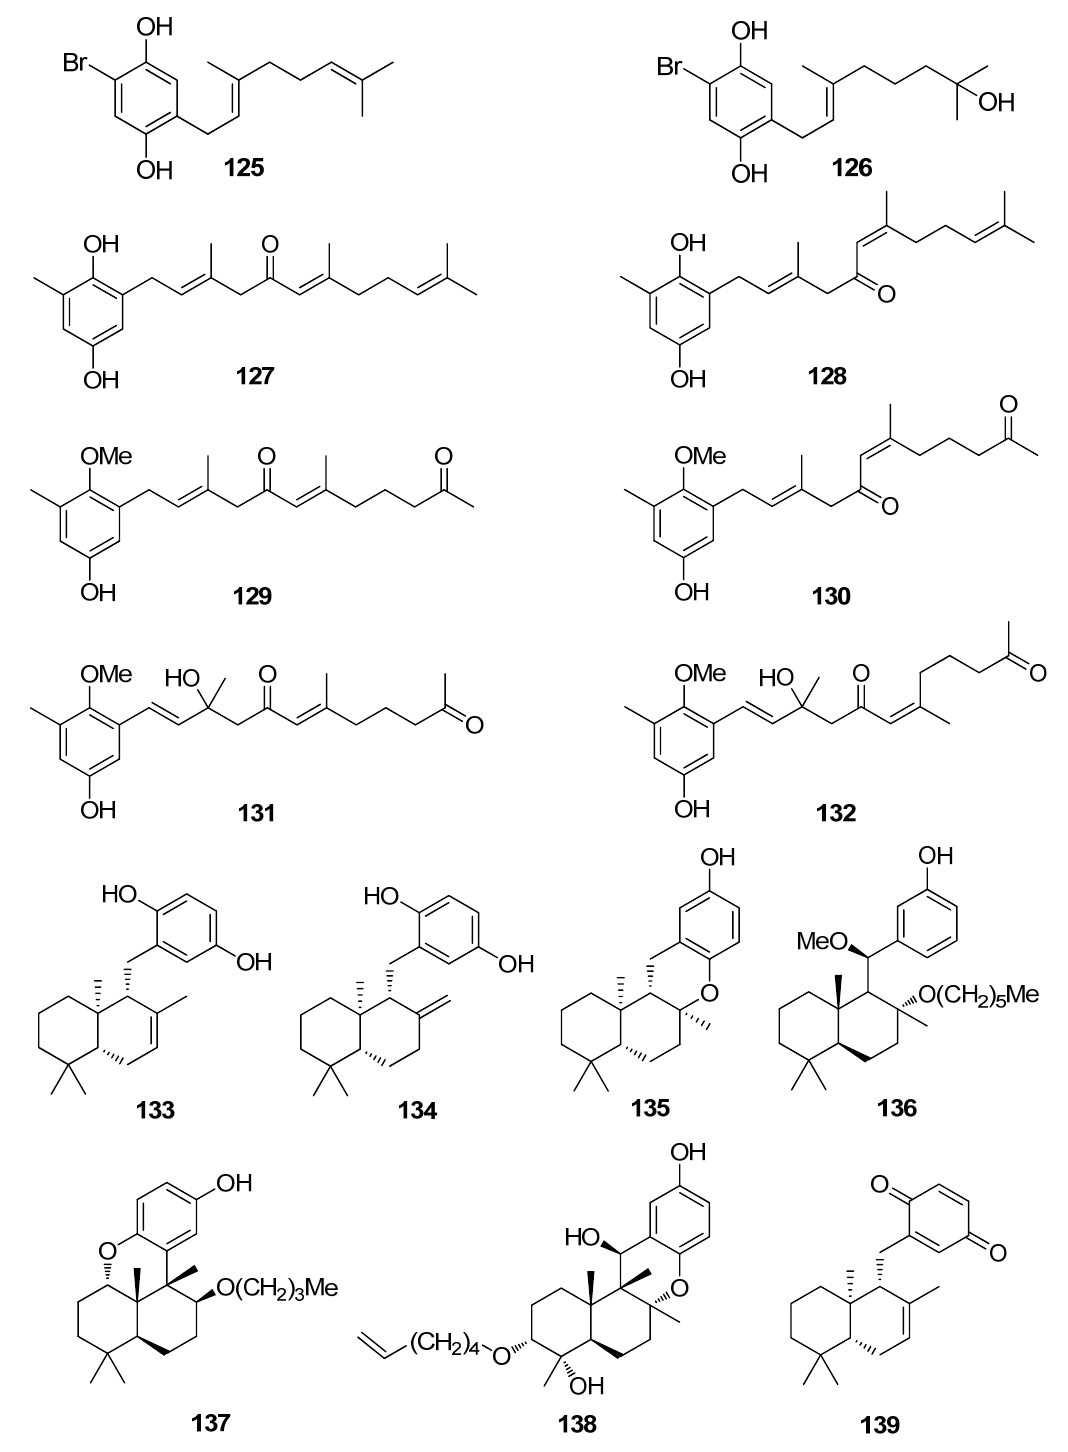
Figure 13. Chemical structures of compounds 125 – 139 .